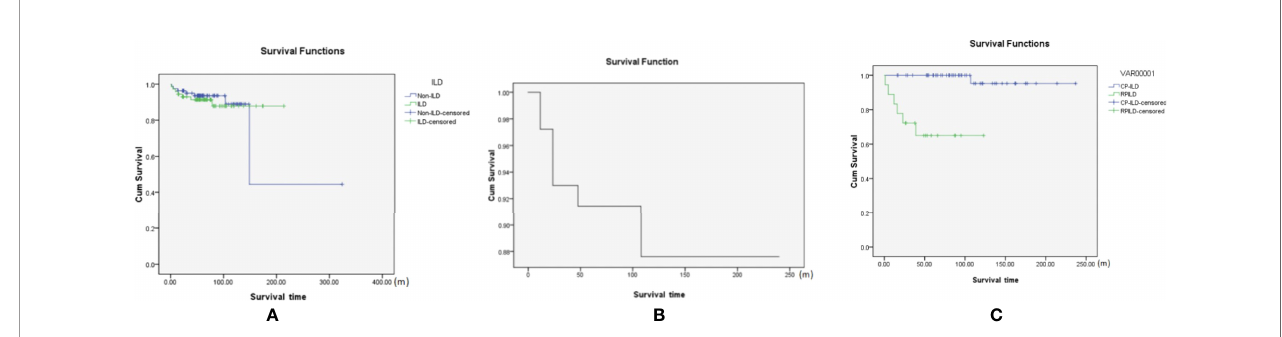
FIGURE 2 | (A) The Kaplan-Meier survival analysis of negative MSA/MAA patients with or without ILD(p>0.05). (B) The cumulative 5 and 10-year survival rate of the DM-ILD patients with negative MSA/MAA was 91% and 88%; (C) Kaplan-Meier survival analysis of RP-ILD and CP-ILD patients with negative MSA/MAA (with